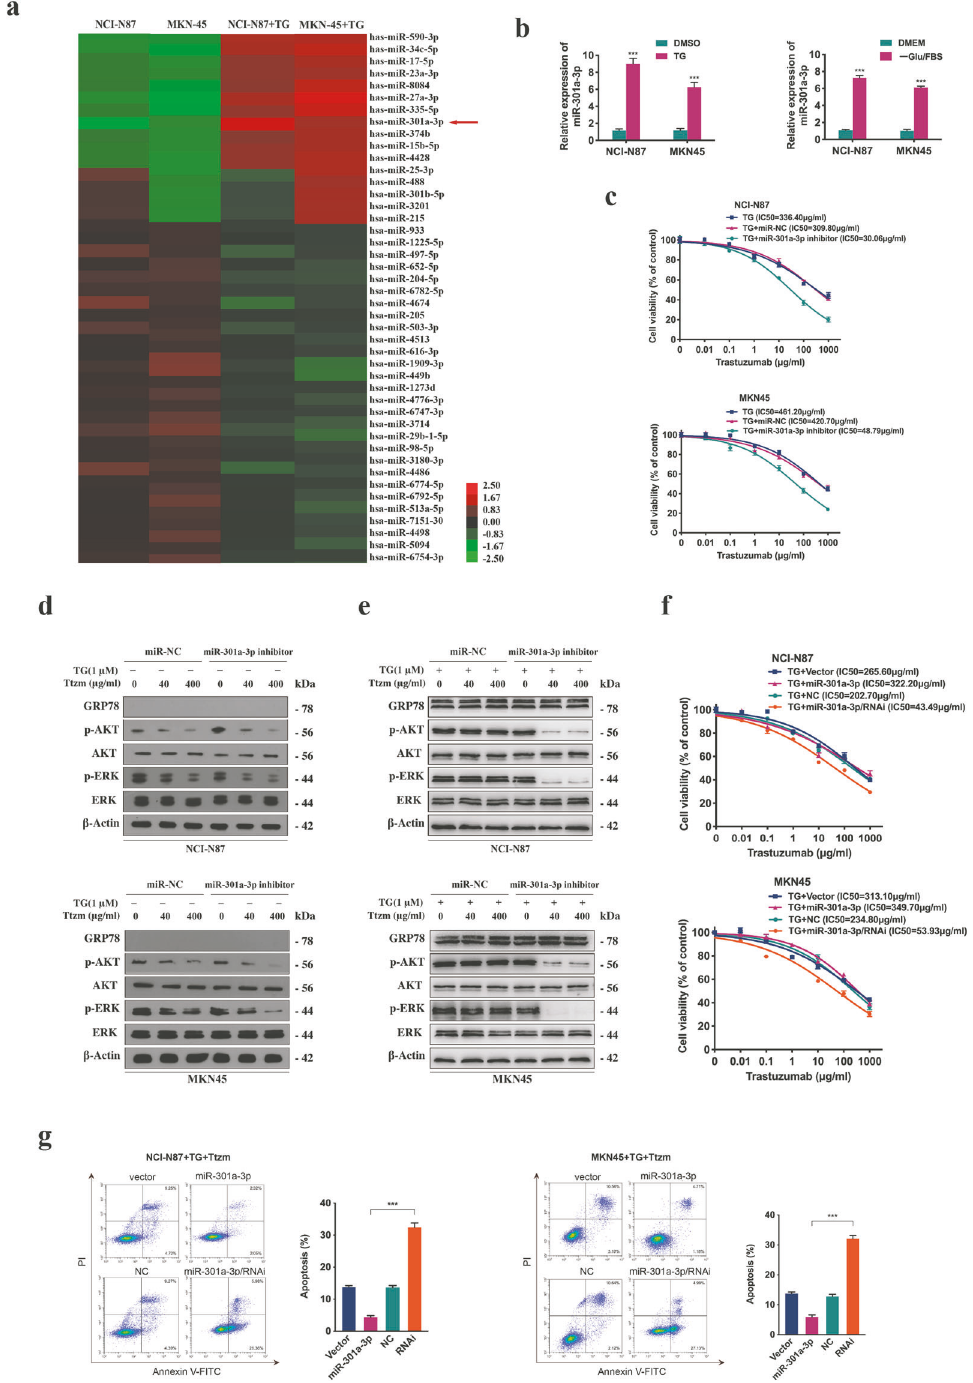
Fig. 2 Identi fi cation of miR-301a-3p and the effect on trastuzumab resistance. a Microarray assay of NCI-N87 and MKN45 cells which were treated with or without 1 μ M TG for 12 h. Hierarchical clustering of the expression levels of miRNAs in cells. Red and green represent high or low relative expression, respectively. Increased and decreased miRNAs levels were determined by P < 0.05 and >2.5 folds difference in expression compared with the blank control. The arrow represents miR-301a-3p. b The relative expression level of miR-301a-3p level in NCI- N87 and MKN45 cells treated with 1 μ M TG for 12 h or -Glu/FBS for 24 h. c CCK8 assay of NCI-N87 and MKN45 cells after transfection with miR- 301a-3p inhibitor or control agents before trastuzumab treatment at indicated concentrations for 72 h ( n = 3). d Protein level in NCI-N87 and MKN45 cells after transfection with miR-301a-3p inhibitors or control followed by 40 or 400 μ g/ml trastuzumab treatment for 72 h. e The certain proteins in NCI-N87 and MKN45 cells after transfection with miR-301a-3p inhibitors or control detected by Western blot. The cells were treated with 1 μ M TG for 12 h followed by 40 or 400 μ g/ml trastuzumab treatment for 72 h. f CCK8 assay of miR-301a-3p stably transfected and control cells. The NCI-N87 and MKN45 cells were treated with 1 μ M TG for 12 h followed by trastuzumab treatment for 72 h ( n = 3). g Flow cytometry was used to measure the apoptosis of miR-301a-3p stably transfected and control cells after treated with 1 μ M TG for 12 h followed by 400 μ g/ml trastuzumab treatment for 72 h ( n = 3). Statistical analysis was performed by Student ’ s t -test, error bars indicate SD (*** p <